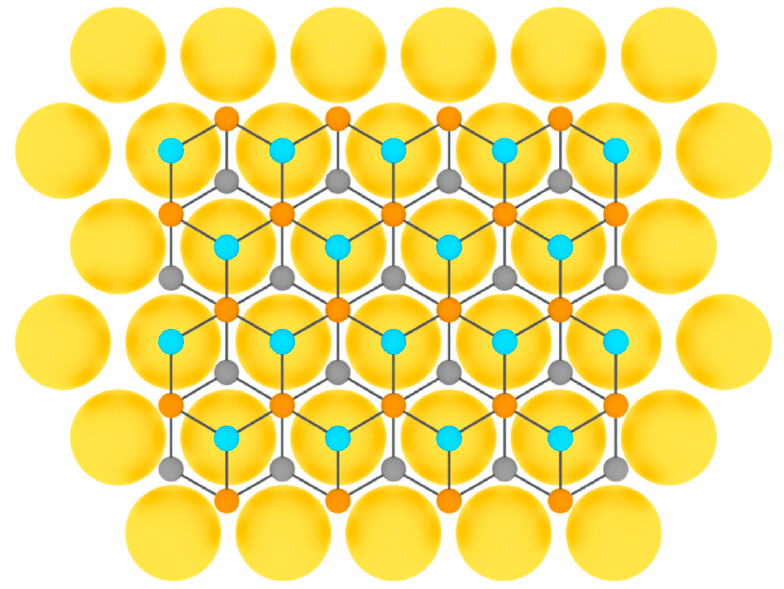
Figure 9. Model of tellurene layer on a substrate (three colors are used for tellurium atoms at different height positions).